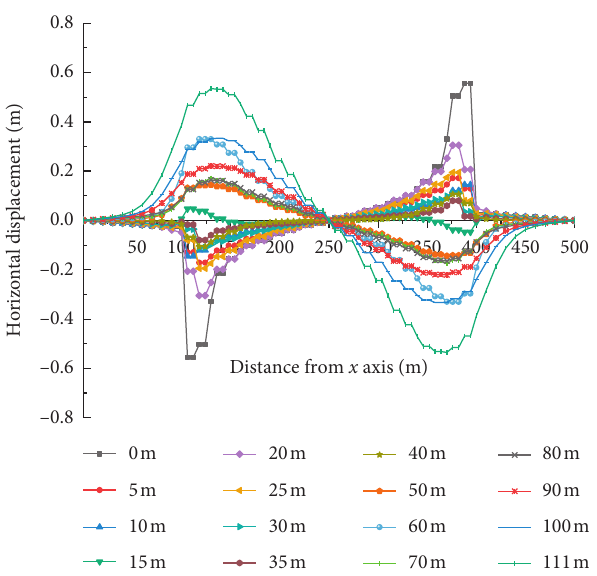
Figure 11: Distribution of horizontal displacement on inclination observation surface.